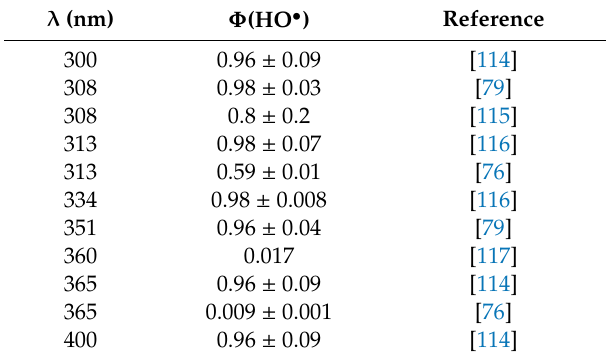
Table 2. Summary of HO • quantum yields ( Φ OH ) for H 2 O 2 photolysis in aqueous solution at di ff erent photolysis